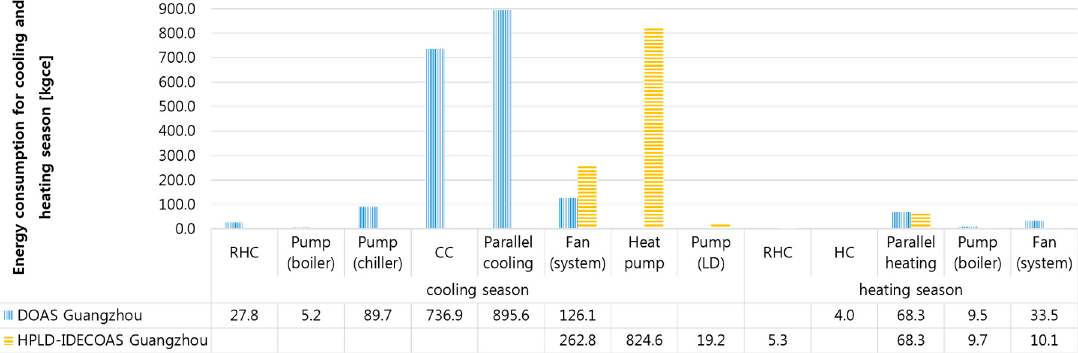
Figure 21. Comparison of seasonal energy consumption in Guangzhou.